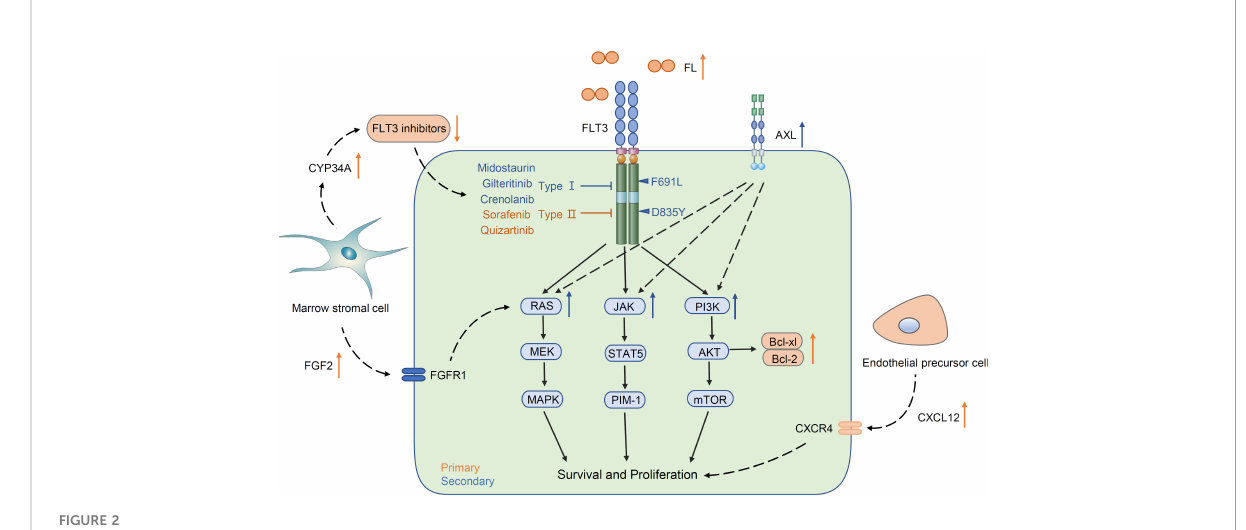
FIGURE 2 Common mechanisms of primary and secondary